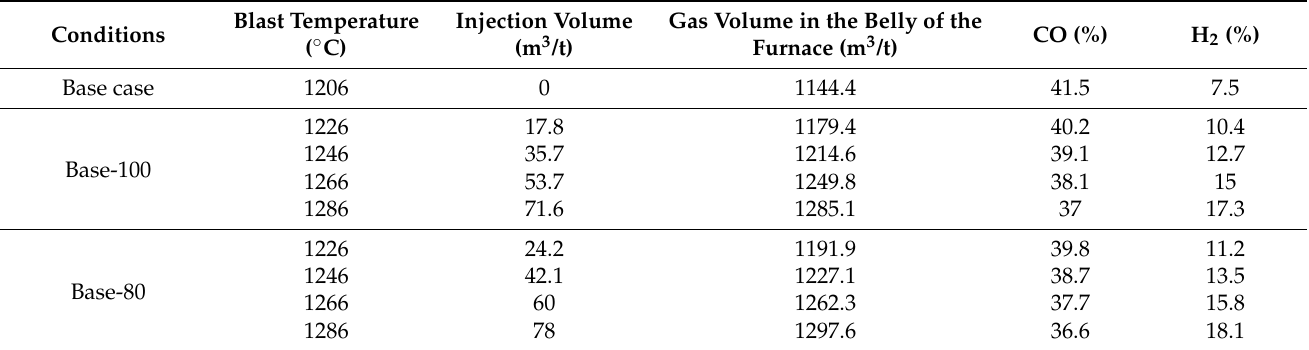
Table 6. Influence of acceptable quantities of NG on the volume and composition of bosh gas under different blast temperatures.